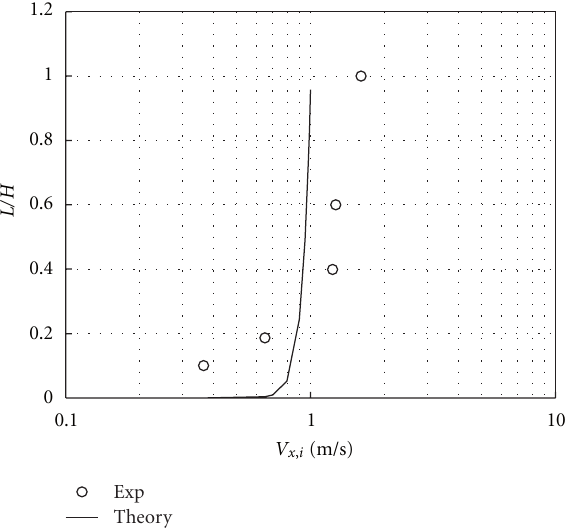
Figure 13: Lift-o ff height for 85% N 2 -15% C 3 H 8 by volume mixture, Sc = 1 .